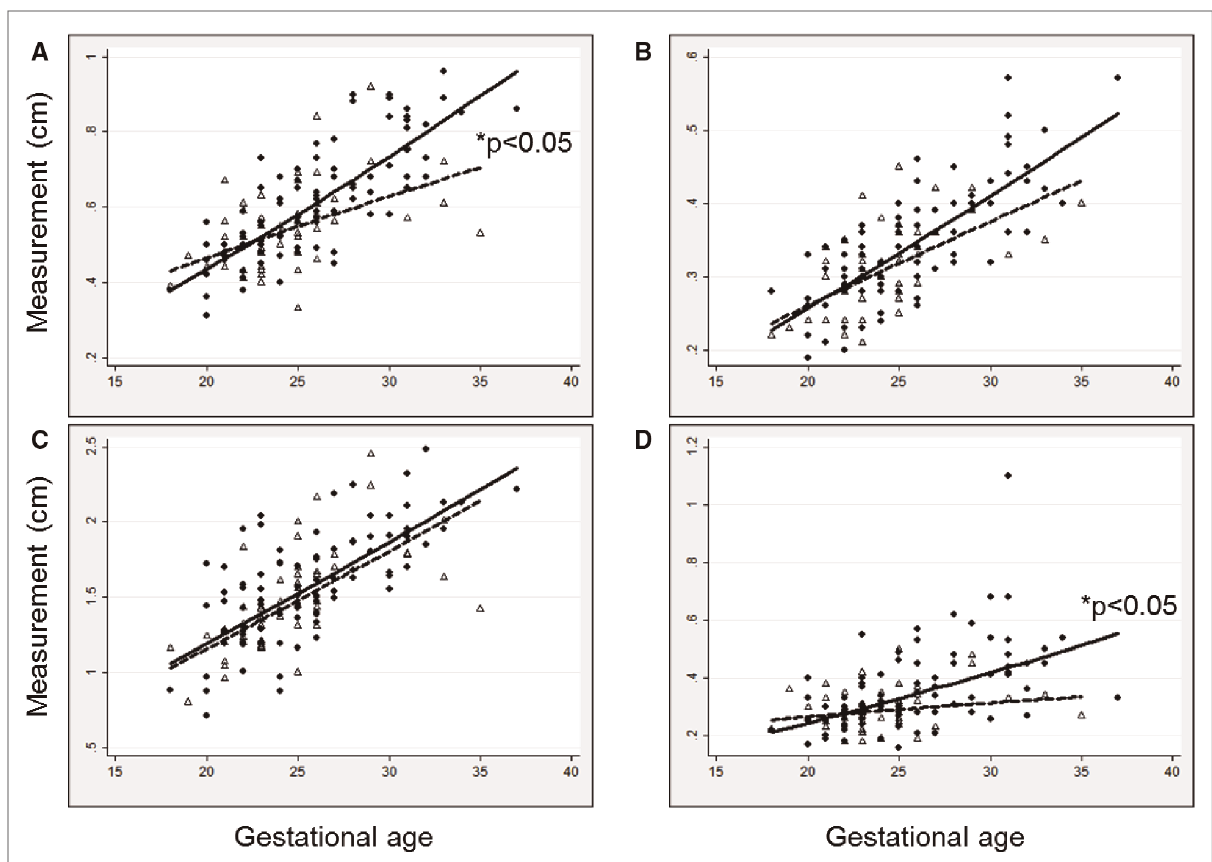
FIGURE 1 Measured left heart structures and left CDH-speci fi c regression lines versus gestational age at measurement in survivors (solid circles, solid line) and a comparison group of non-survivors (open triangles, dashed line), ( A ) mitral valve diameter; ( B ) aortic valve diameter; ( C ) left ventricle length; ( D ) left ventricle width. Regression lines are back-transformed from natural log models. * P- value for interaction between survival and gestational